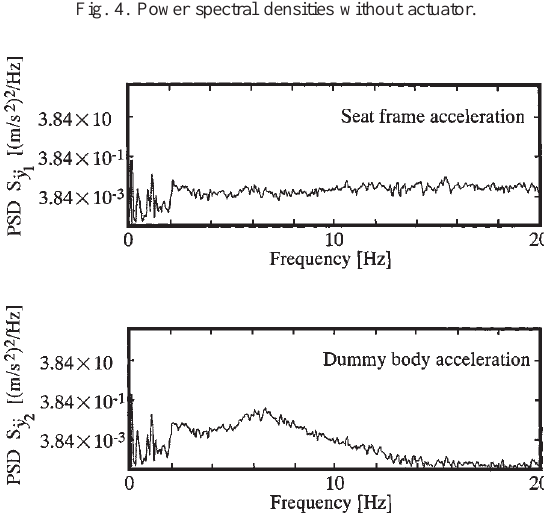
Fig. 4. Power spectral densities without actuator.